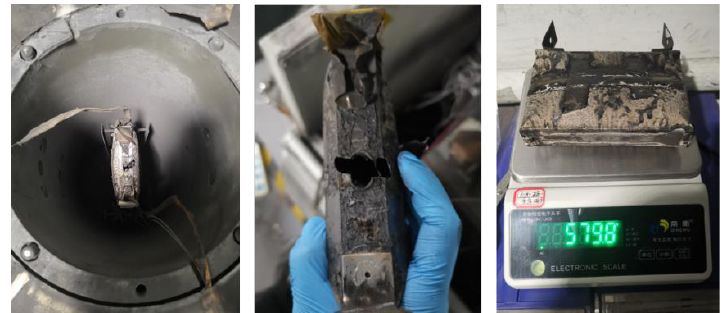
Figure 8. Wreckage of the cell after EV-ARC test.